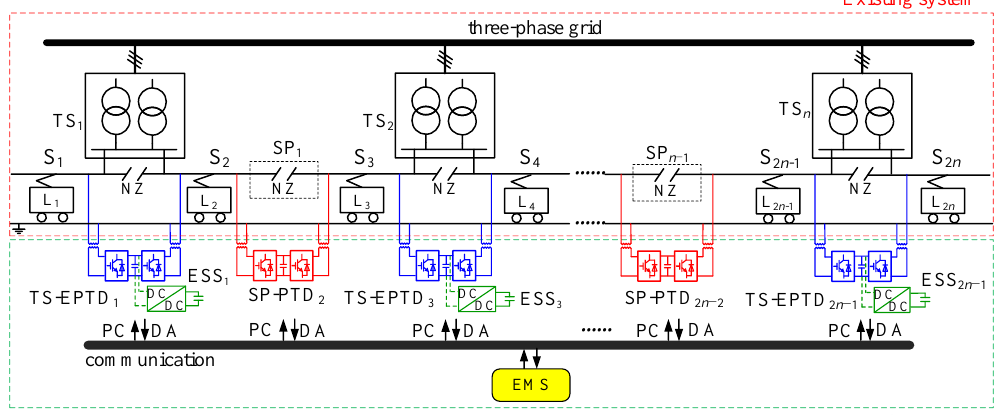
Figure 3. The railway traction system with energy-storage-based smart electrical infrastructure.